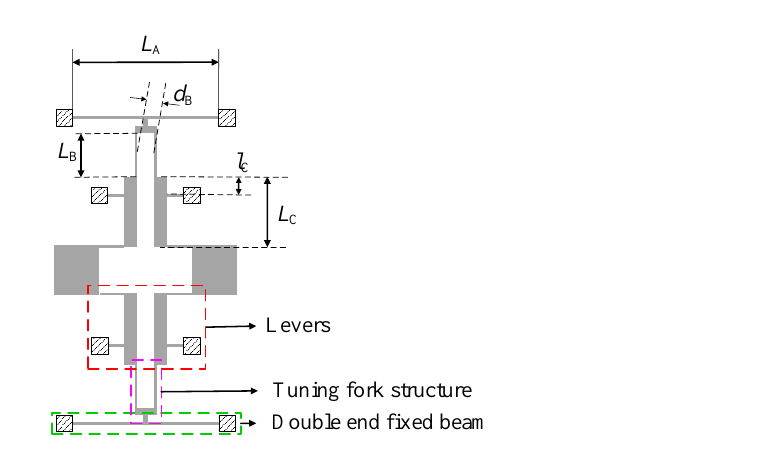
Figure 5. The proposed coupling